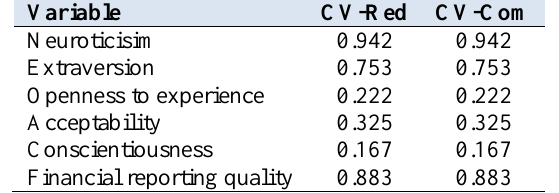
Table 3. CV-Red and CV-Com index values for research model variables